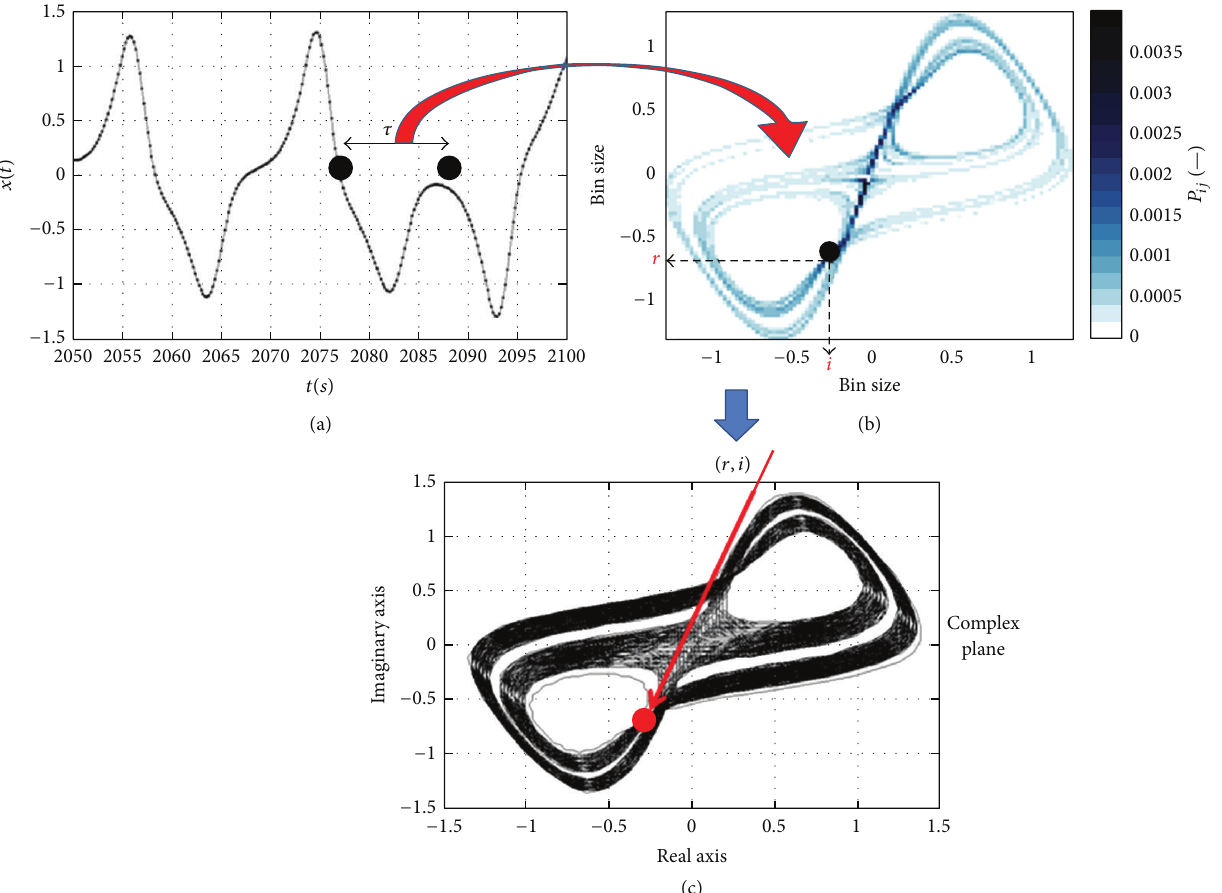
Figure 2: Complex surrogate approach. (a) Lorenz model 𝑋 -coordinate; (b) detail of the probability projection surface, PS; (c) complex representation of the probability projection